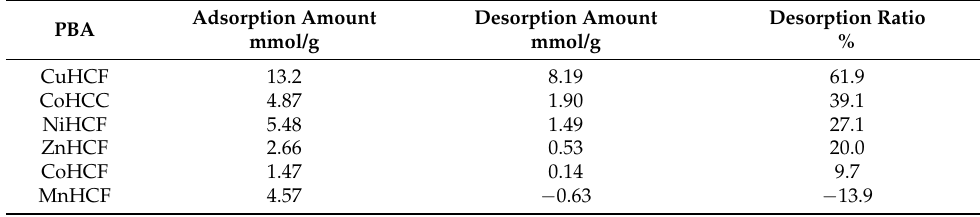
Table 1. The adsorption and desorption amount of NH 3 and the ratio of